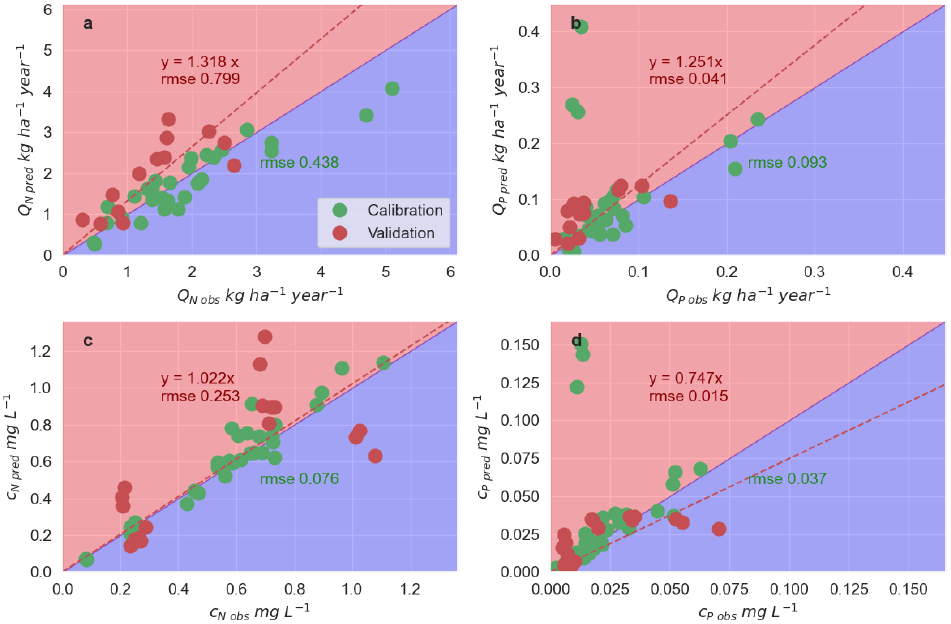
Figure 5. Scatterplots between observed and predicted annual export loads of nitrogen ( a ) and phosphorus ( b ), and observed and predicted mean annual nitrogen ( c ) and phosphorus concentration ( d ) in calibration (green dots) and test catchments (red dots). The dashed red line is a regression line (equation in the figure) for the test